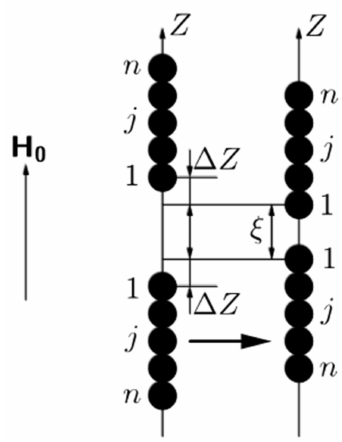
Figure 13. Illustration of the chains’ displacement towards each other. Left—the relative position of the chains immediately after their formation; right—after the displacement. Horizontal arrow—evolution in